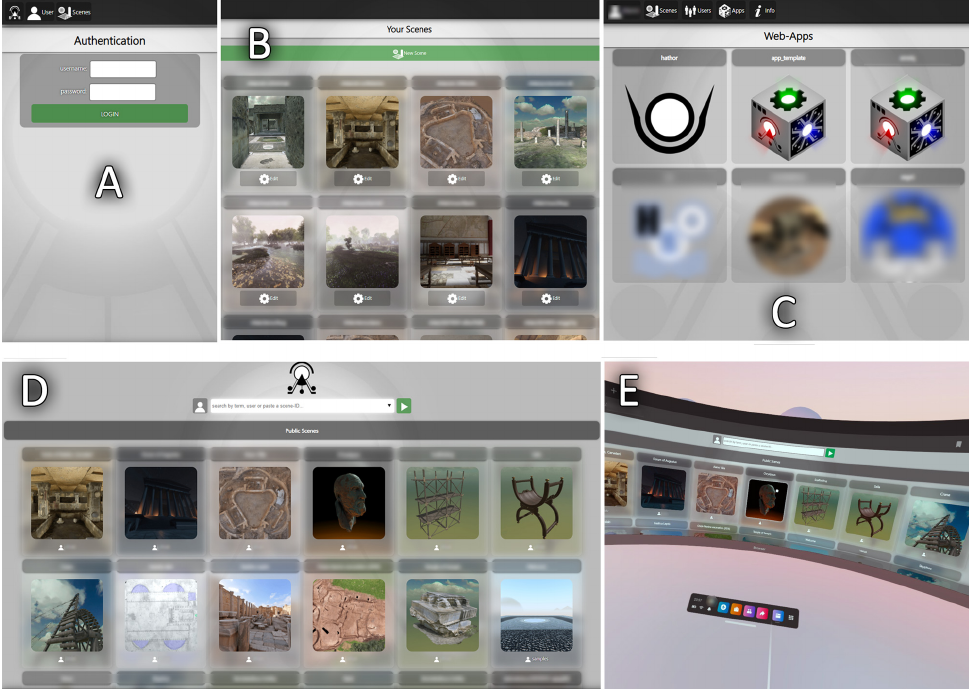
Figure 5. Shu back-end. Authentication ( A ); private scenes gallery ( B ); web-applications gallery ( C );